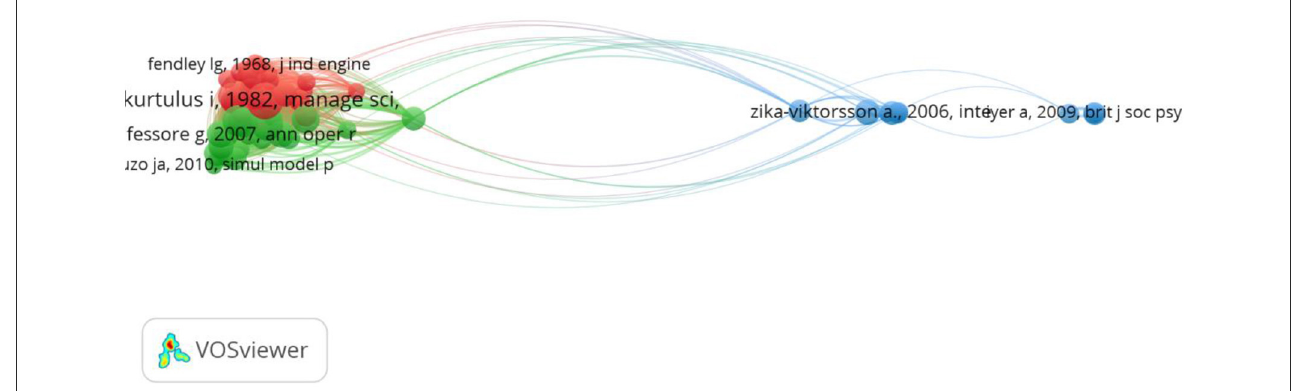
FIGURE3 Co-citation analysis based on 59 papers.